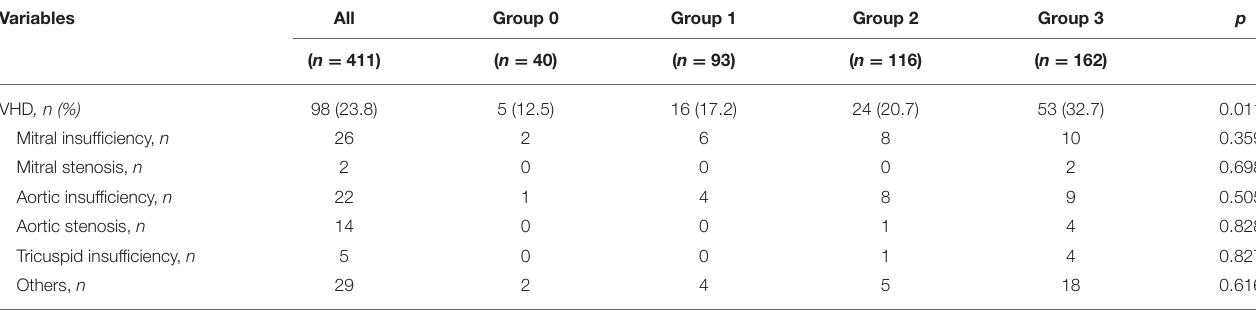
TABLE 2 | VHD prevalence, stratified according to AHI